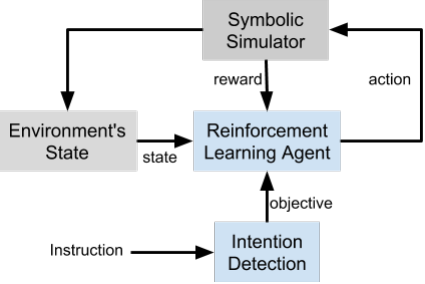
Figure 1: The modular approach using intention detection and re-